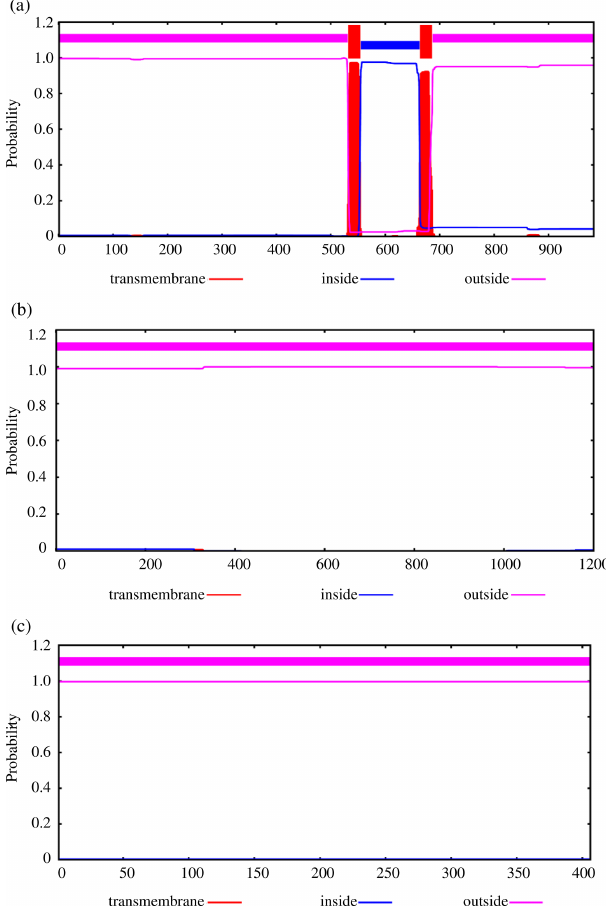
Figure 2. Transmembrane regions’ prediction using the amino acid sequence reported in TMHMM, including FLT3 (a) , NLRP5 (b) , and TGIF1 (c)